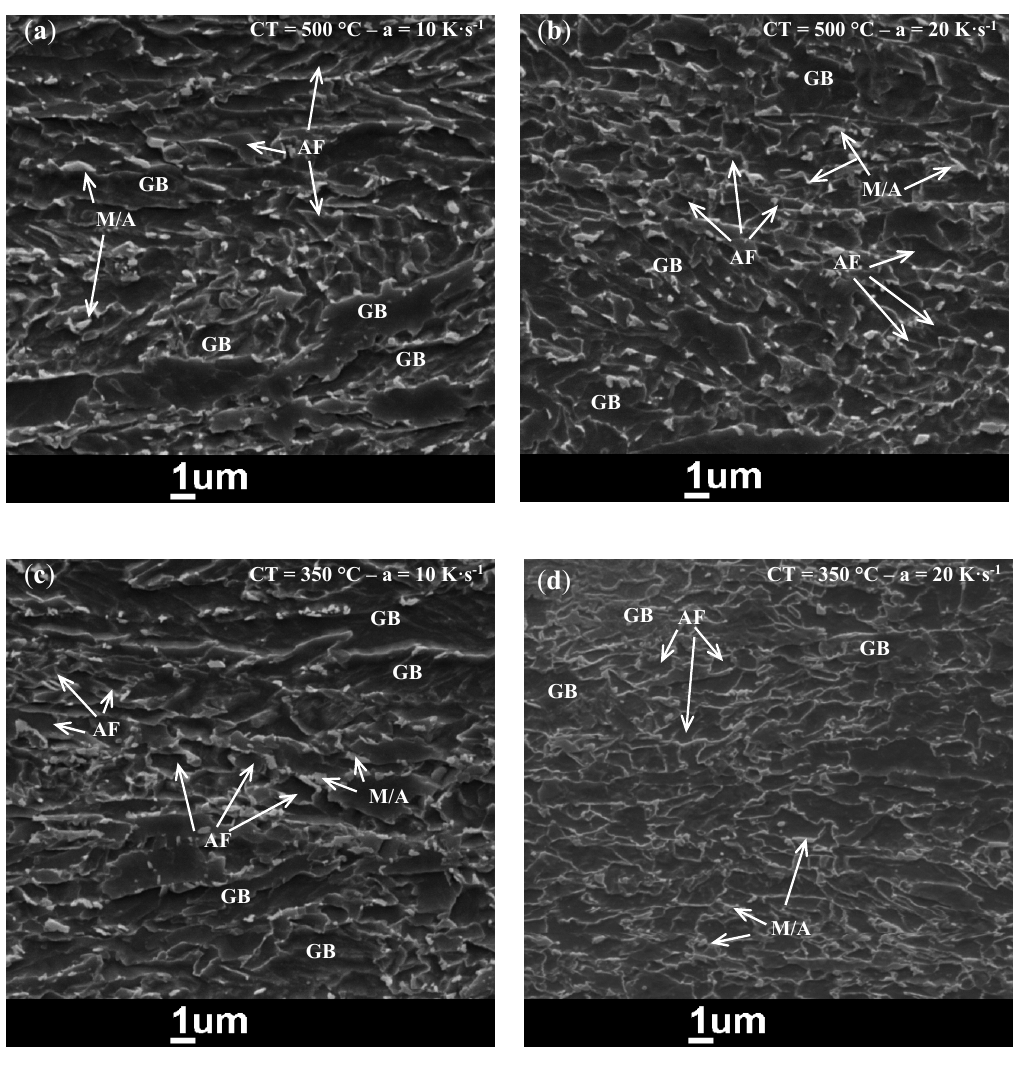
Figure 8. Scanning electron micrographs of samples processed under the prescribed conditions and having FRT = 840 °C. ( a , b ) for CT = 500 °C and ( c , d ) for CT = 350 °C.